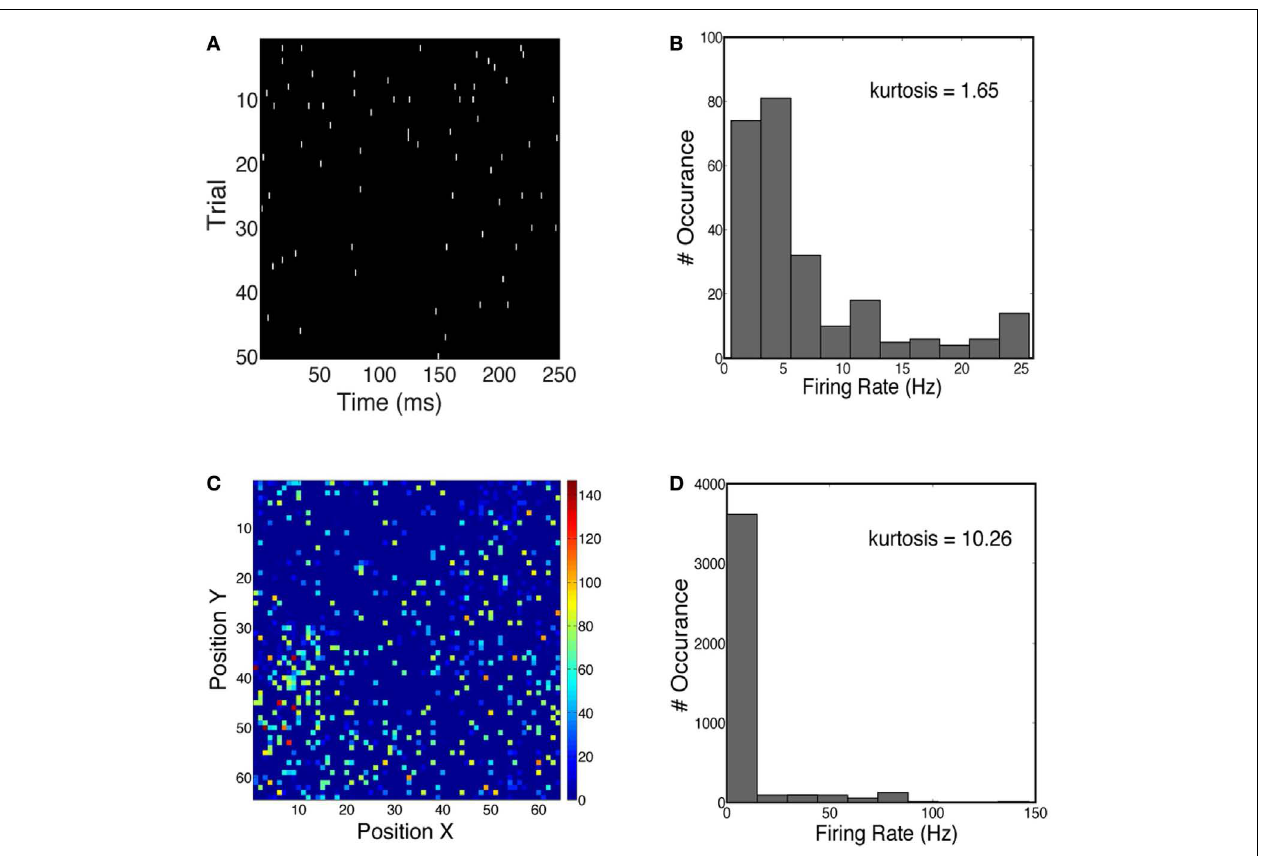
firing rates over all neurons in the network. Firing rates are computed at 50ms post-stimulus for one trial. (D) Distribution of firing rates has a kurtosis of